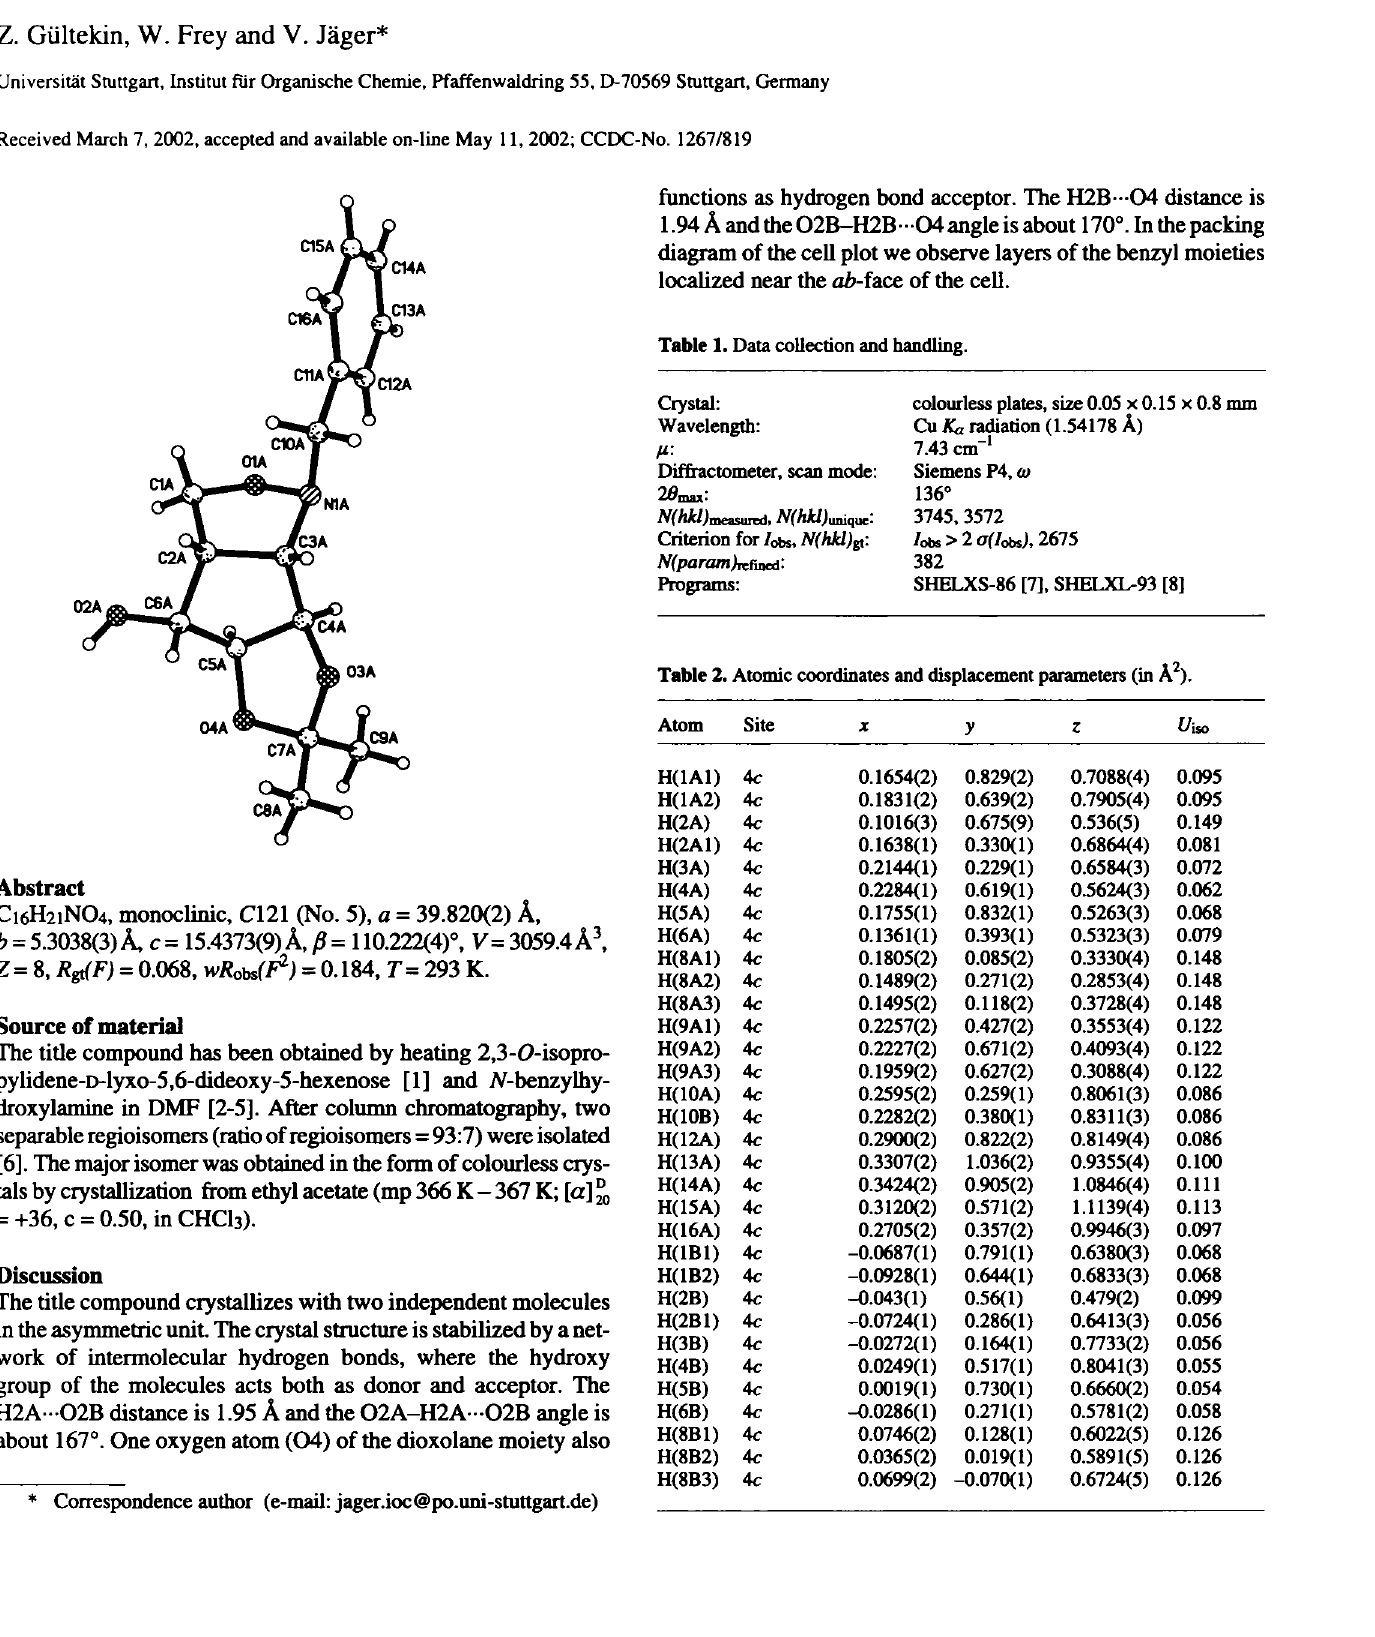
functions as hydrogen bond acceptor. The H2B—04 distance is 1.94 Â and the 02B-H2B · • 04 angle is about 170°. In the packing diagram of the cell plot we observe layers of the benzyl moieties localized near the a¿-face of the cell. Table 1. Data collection and handling.